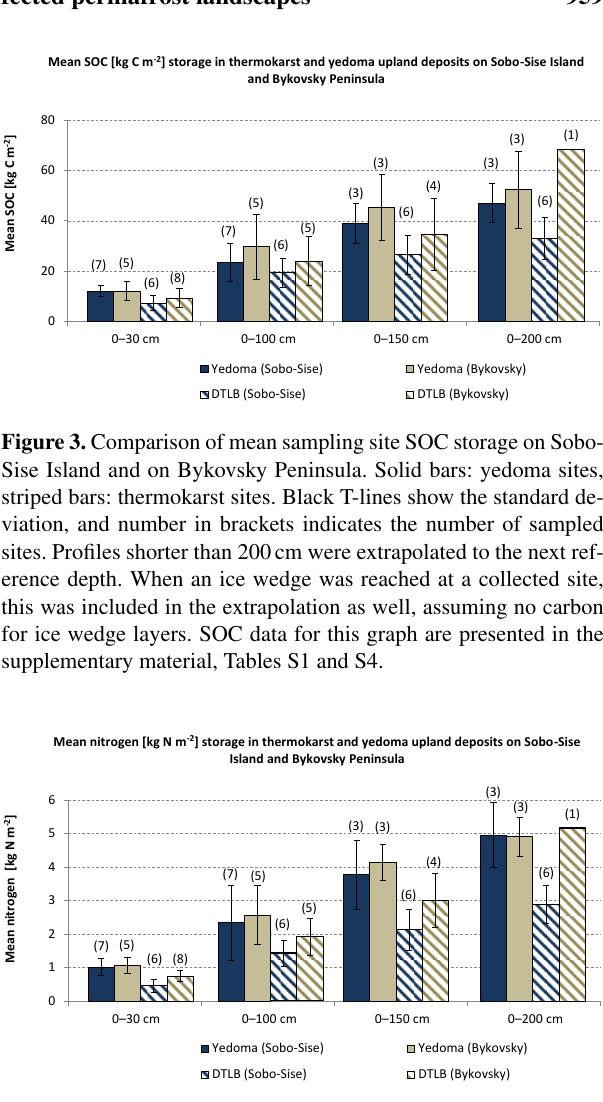
Figure 4. Mean sampling site N storage for the different geomor- phic units in both study areas. Solid bars: yedoma sites, striped bars: thermokarst sites. Black T-lines show the standard deviation and number in brackets indicate the number of sampled sites. Profiles shorter than 200cm were extrapolated to the next reference depth. When reaching an ice wedge in a collected site, this was included in the extrapolation as well, assuming no N for ice wedge layers. Soil N data for this graph are presented in the supplementary mate- rial, Tables S1 and